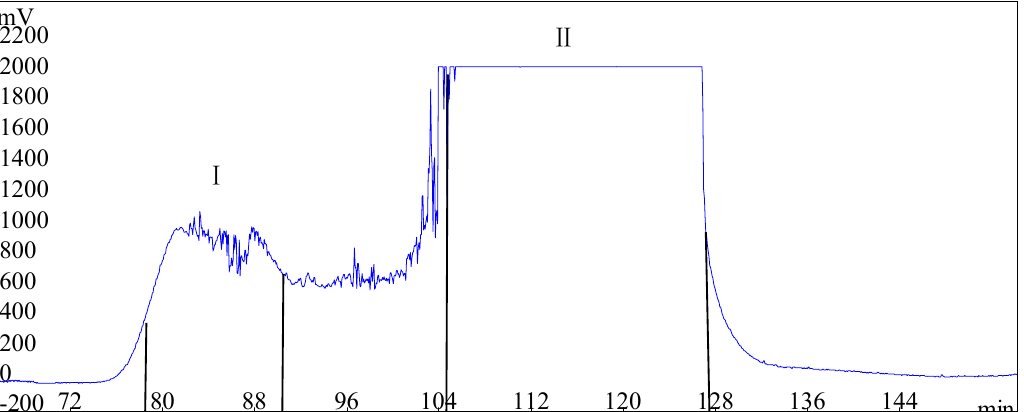
Figure 3. High-speed countercurrent chromatography (HSCCC) chromatogram of the crude extract of Fr592 enriched by multistep column chromatography. Solvent system: N-Hexane/Ethyl acetate/Methanol/Water (1:6:3:4, v / v / v / v ); mobile phase: the upper phase; flow rate: 2.0 mL/min; revolution speed: 860 rpm; detection wavelength: 227 nm; sample size: 100 mg; injection volume: 10 mL; retention of stationary phase: 53.2%.